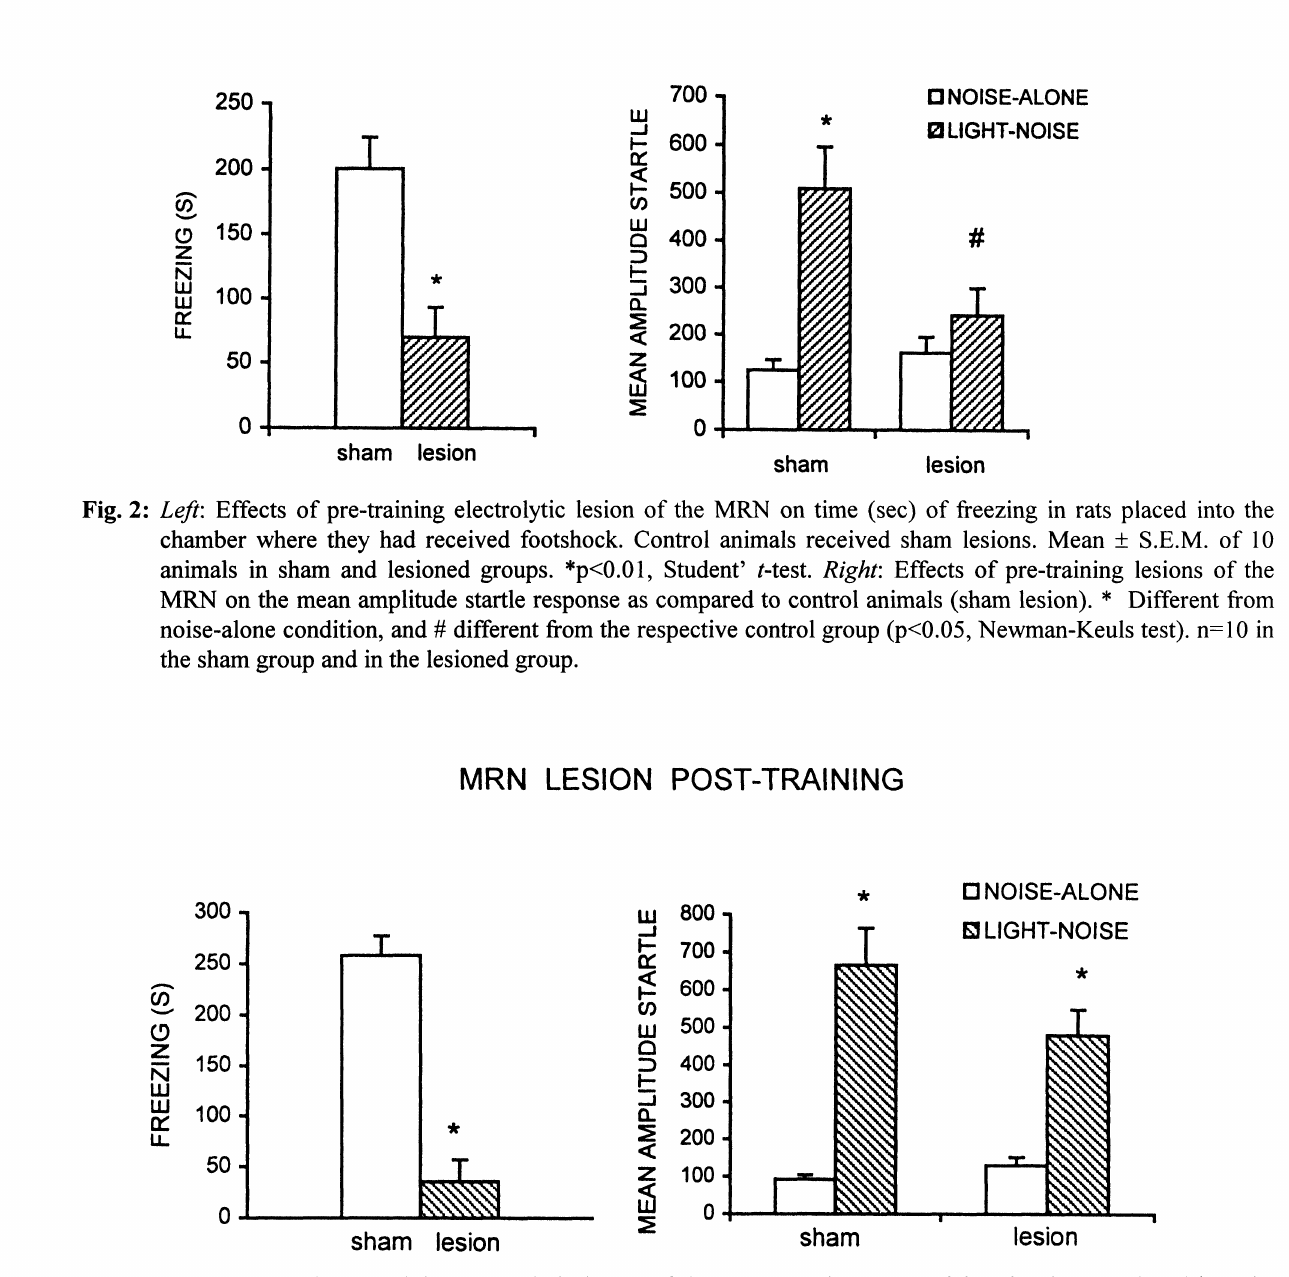
Fig. 3: Left: Effects of post-training electrolytic lesion of the MRN on time (sec) of freezing in rats placed into the chamber where they had received foot-shocks. Control animals received sham lesions. Mean + S.E.M. of 10 animals in sham and lesioned groups. * p<0.001, Student’s t-test. Right: Effects of post-training lesions of the MRN on the mean amplitude startle response as compared to control animals (sham lesion). * Different from noise-alone condition (p<0.05, Newman-Keuls test), n 10 in both